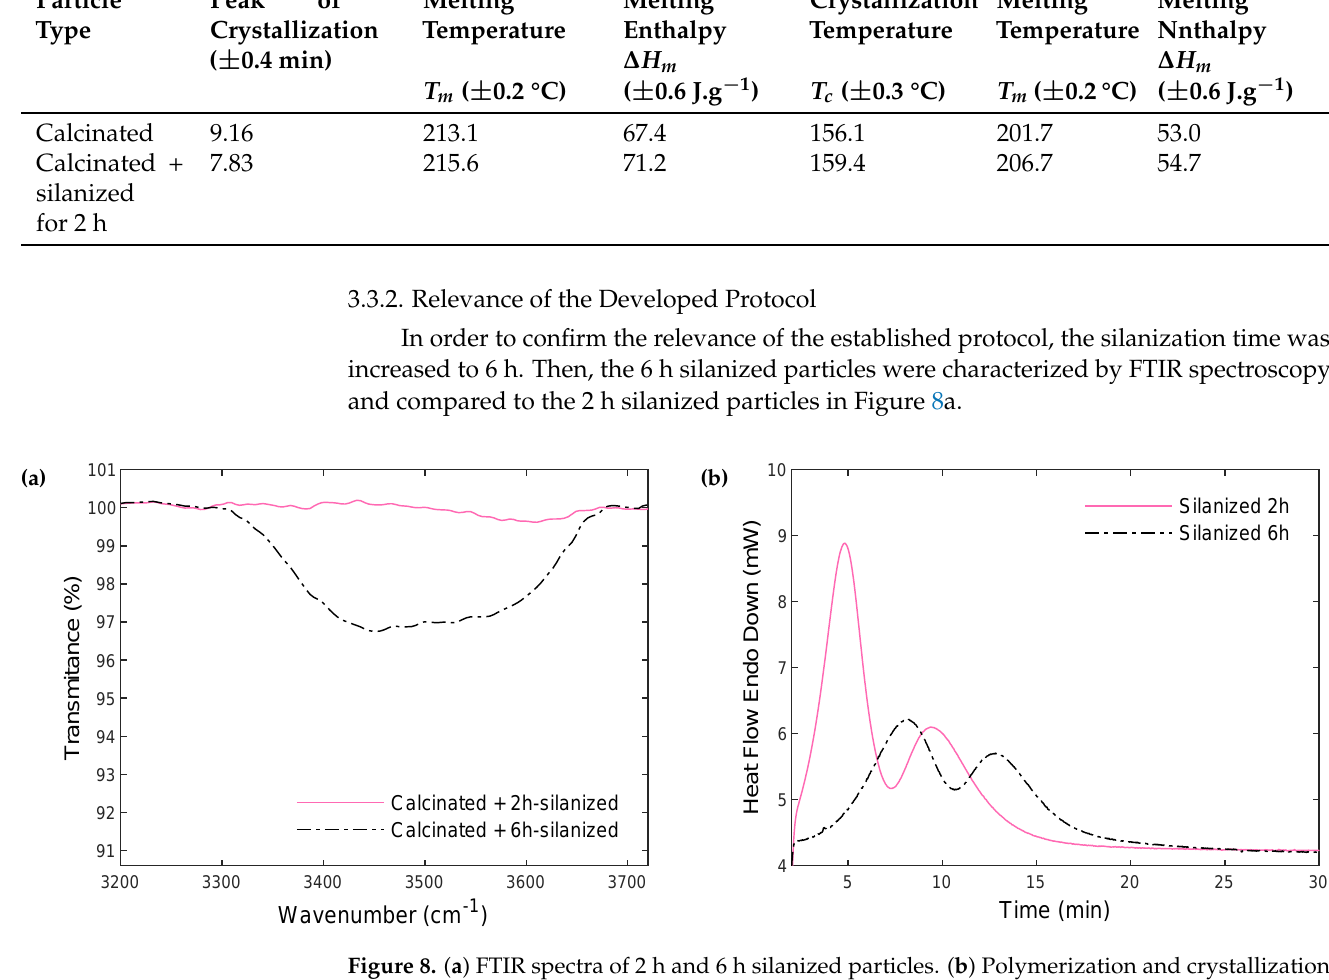
Figure 8. ( a ) FTIR spectra of 2 h and 6 h silanized particles. ( b ) Polymerization and crystallization heat flow curves during isothermal synthesis at 180 ◦ C of composites synthesized with particles silanized for 2 h and 6